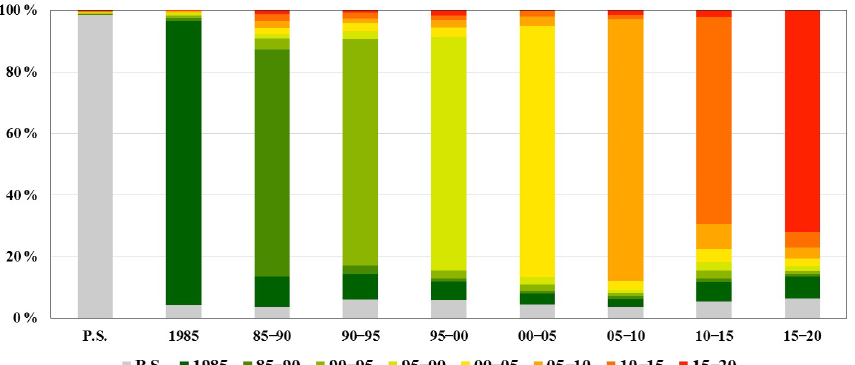
Figure 8. The confusion proportions of pervious surfaces, impervious surfaces in 1985 and increased impervious surfaces from 1985 to